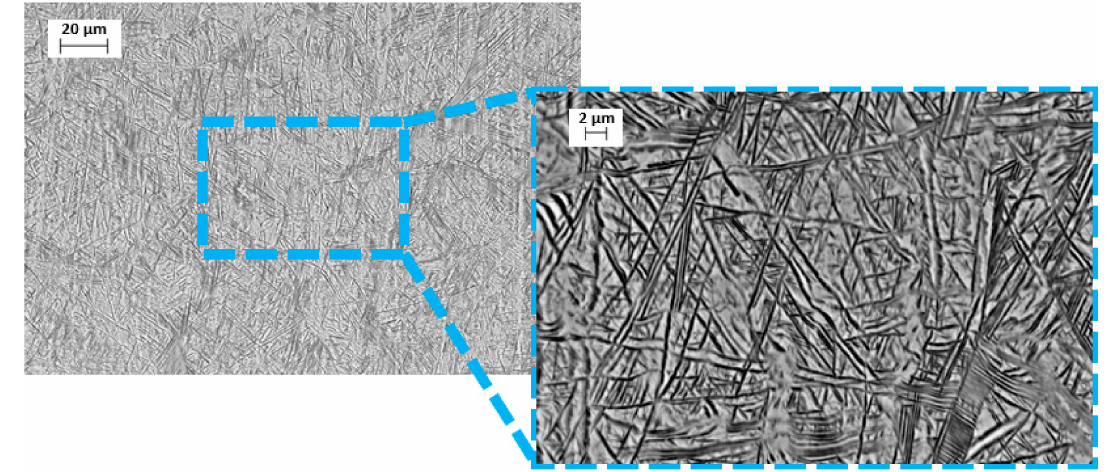
Figure 1. Microscopic image of Ti-13Nb-13Zr alloy microstructure, SEM, BSE. The presence of two phases was verified through X-ray diffraction (XRD) investiga- tions. Figure 2 summarises typical X-ray diffraction pattern for Ti-13Nb-13Zr. All the major peaks were indexed as α -Ti and β -Ti. Bragg’s peak indexation denotes the presence of α -Ti